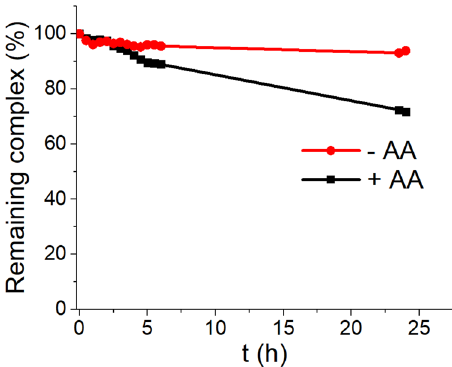
Fig. 2 UHPLC stability kinetic measurements of BSO-OxOAc. The stability of the complex (1 mM) was measured in 100 mM phosphate buffer (pH 7.4; 20 °C) and the reduction in the presence of 10 mM AA in 500 mM phosphate buffer (pH 7.4; 20